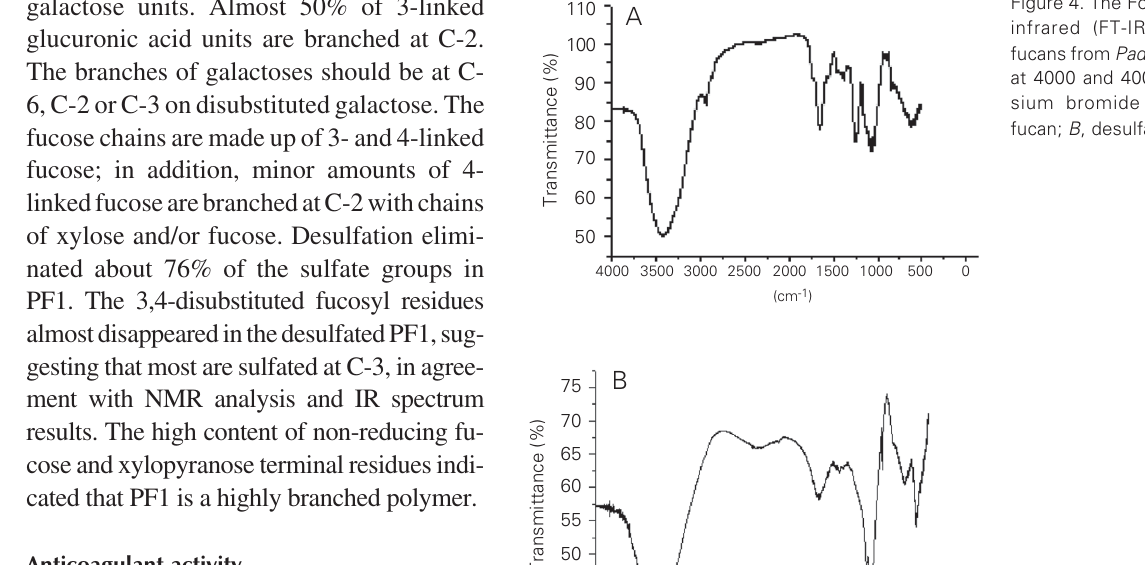
Figure 4. The Fourier transform- infrared (FT-IR) spectrum of fucans from Padina gymnospora at 4000 and 400 cm -1 in potas- sium bromide table. A , PF1 fucan; B , desulfated